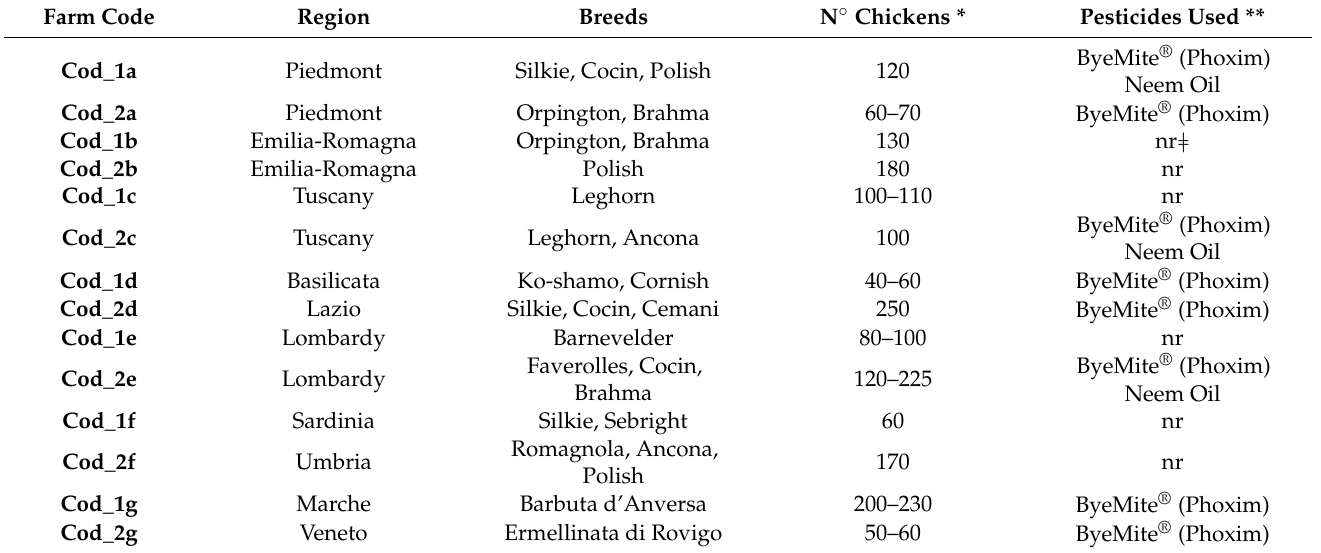
Table 1. Characteristics of the ornamental poultry farms, the breeds raised, and the pesticides used for the treatments against D. gallinae